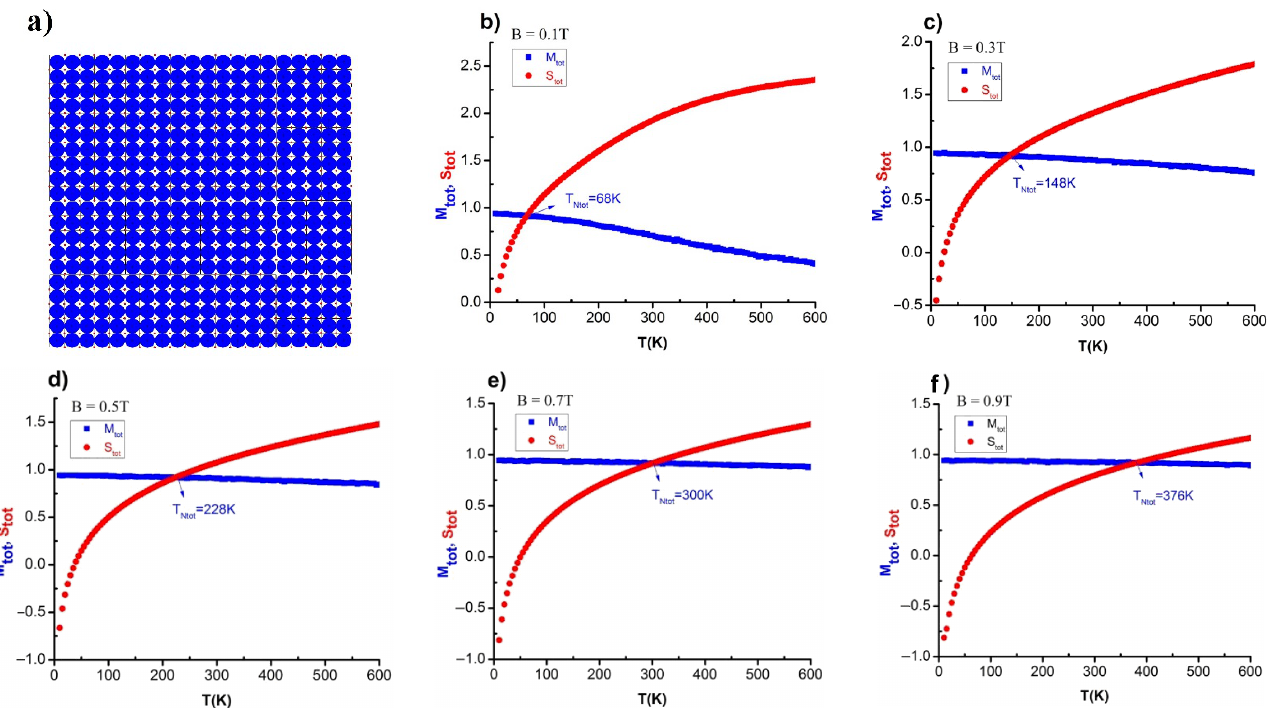
Figure 5. Shape ( a ), Néel phase transition temperature of Fe 2 O 3 nano synthetic thin film with L = 130 nm, rotation angle α = 90° for different magnetic fields B = 0.1 T ( b ), B = 0.3 T ( c ), B = 0.5 T ( d ), B = 0.7 T ( e ), and B = 0.9 T ( f ).